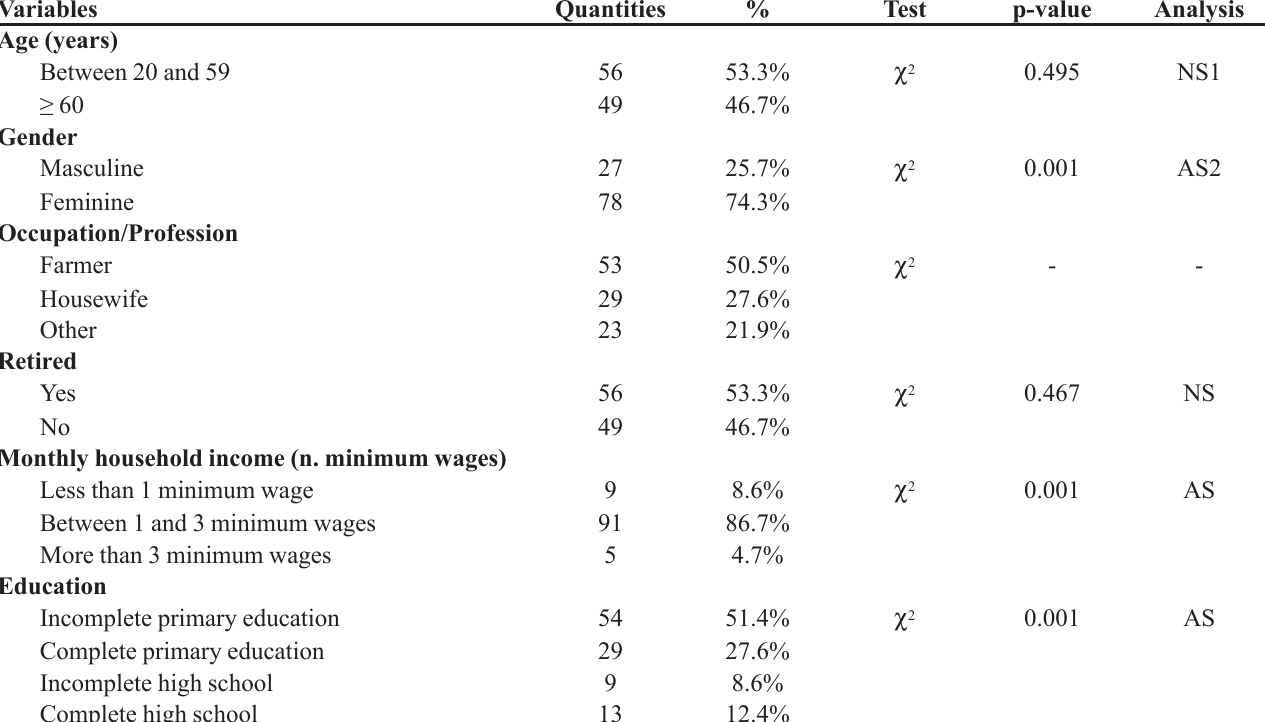
TABLE I - Distribution of sociodemographic and economic variables of Hiperdia users (Applying the Chi Square analysis of variables